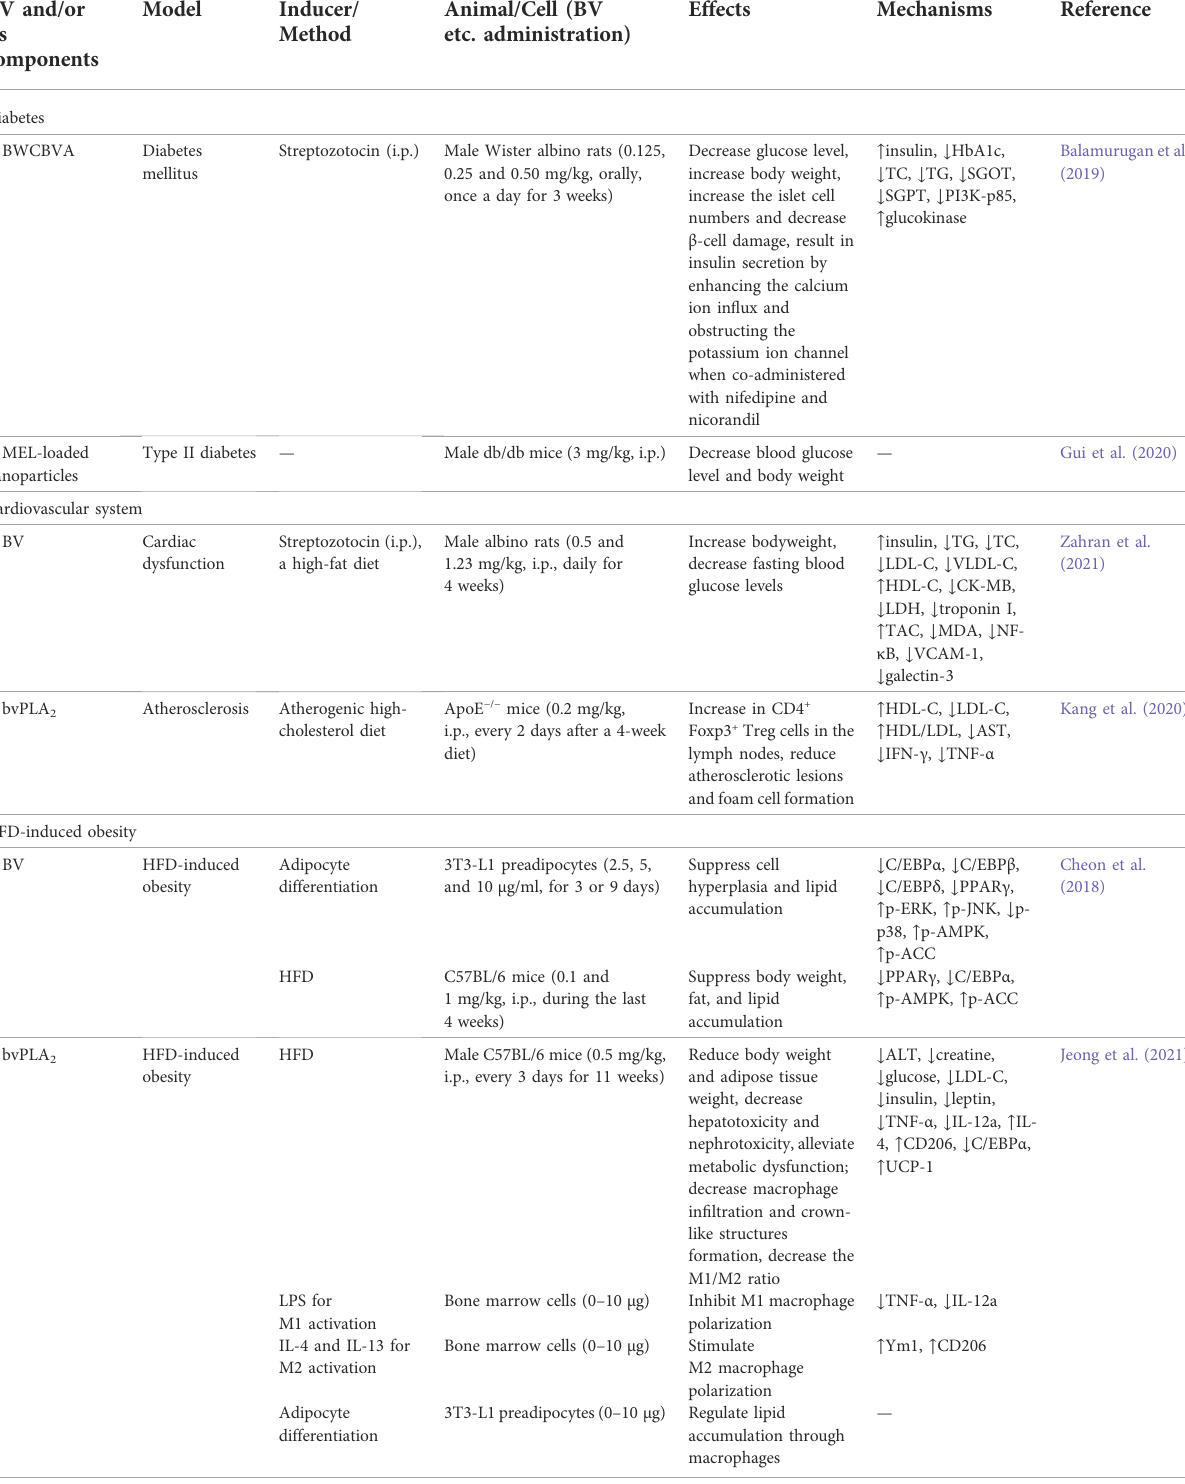
TABLE 7 Summary of the protect effects and mechanisms of BV and its main components on other